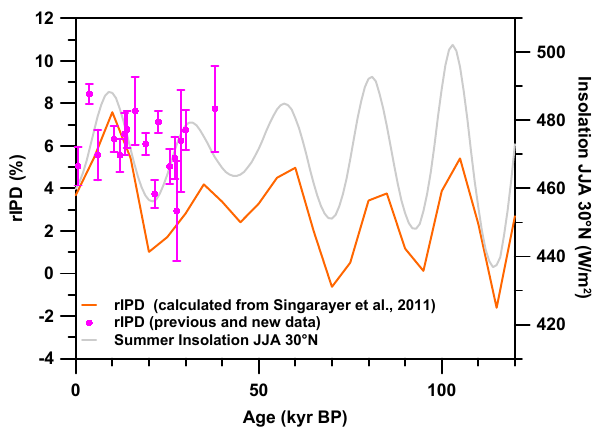
Fig. 8. rIPD long-term trend estimated from the CH 4 source dis- tribution by Singarayer et al. (2011). The rIPD (orange) was cal- culated according to Eqs. (8) and (9). Measured rIPD data (Brook et al., 2000; Chappellaz et al., 1997, and new data) are shown in pink. Northern summer insolation (JJA) (30 ◦ N) is plotted in grey (Quinn et al.,